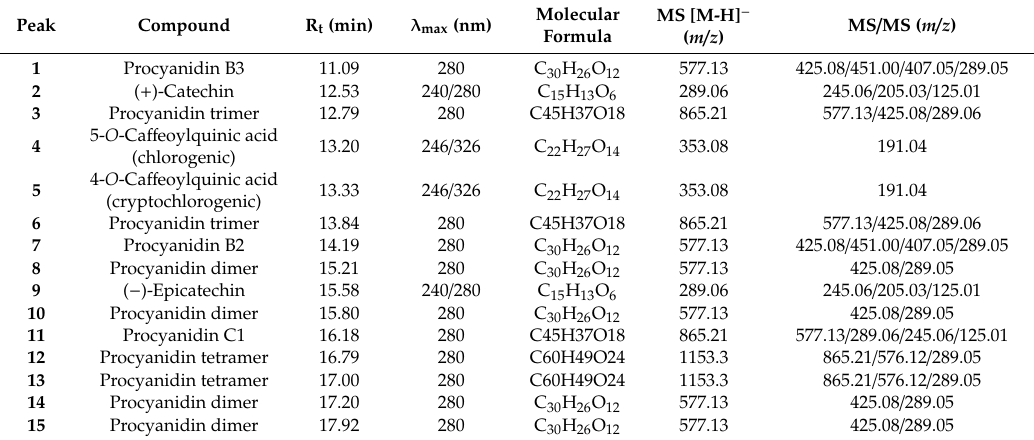
Table 2. Identification of phenolic compounds in Chaenomeles fruits on example Chaenomeles × superba ‘Texas Scarlet’ by using liquid chromatography coupled with photodiode array detector and